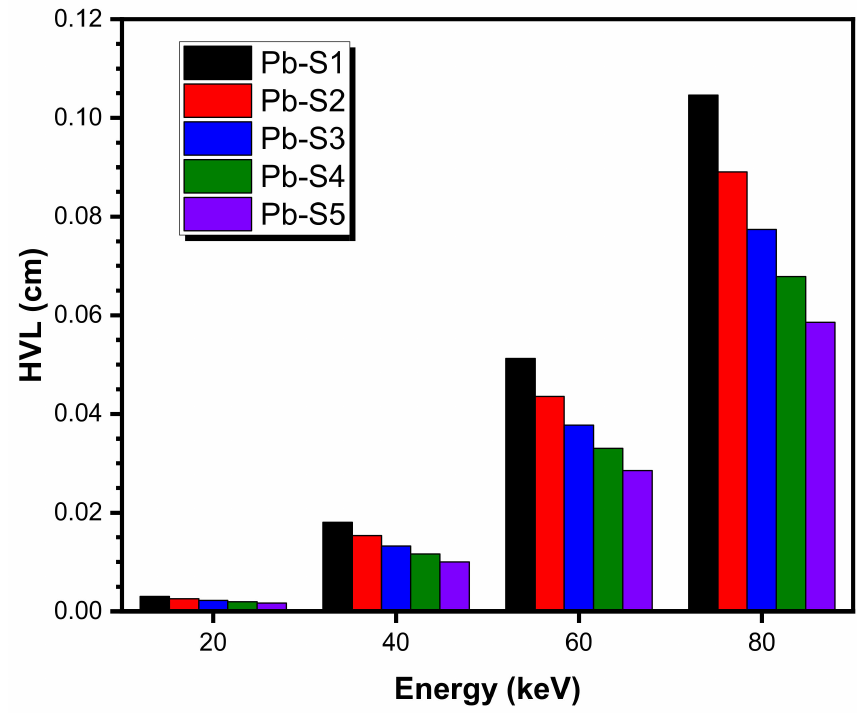
Figure 7. The HVL for the Pb-SX glasses at four energies (20, 40, 60 and 80 keV).